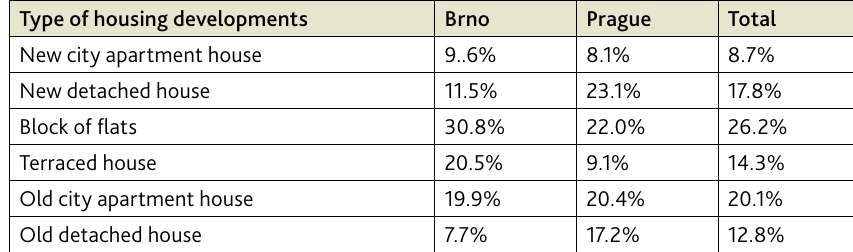
Table 1. Percentage of respondents based on types of housing developments at their places of